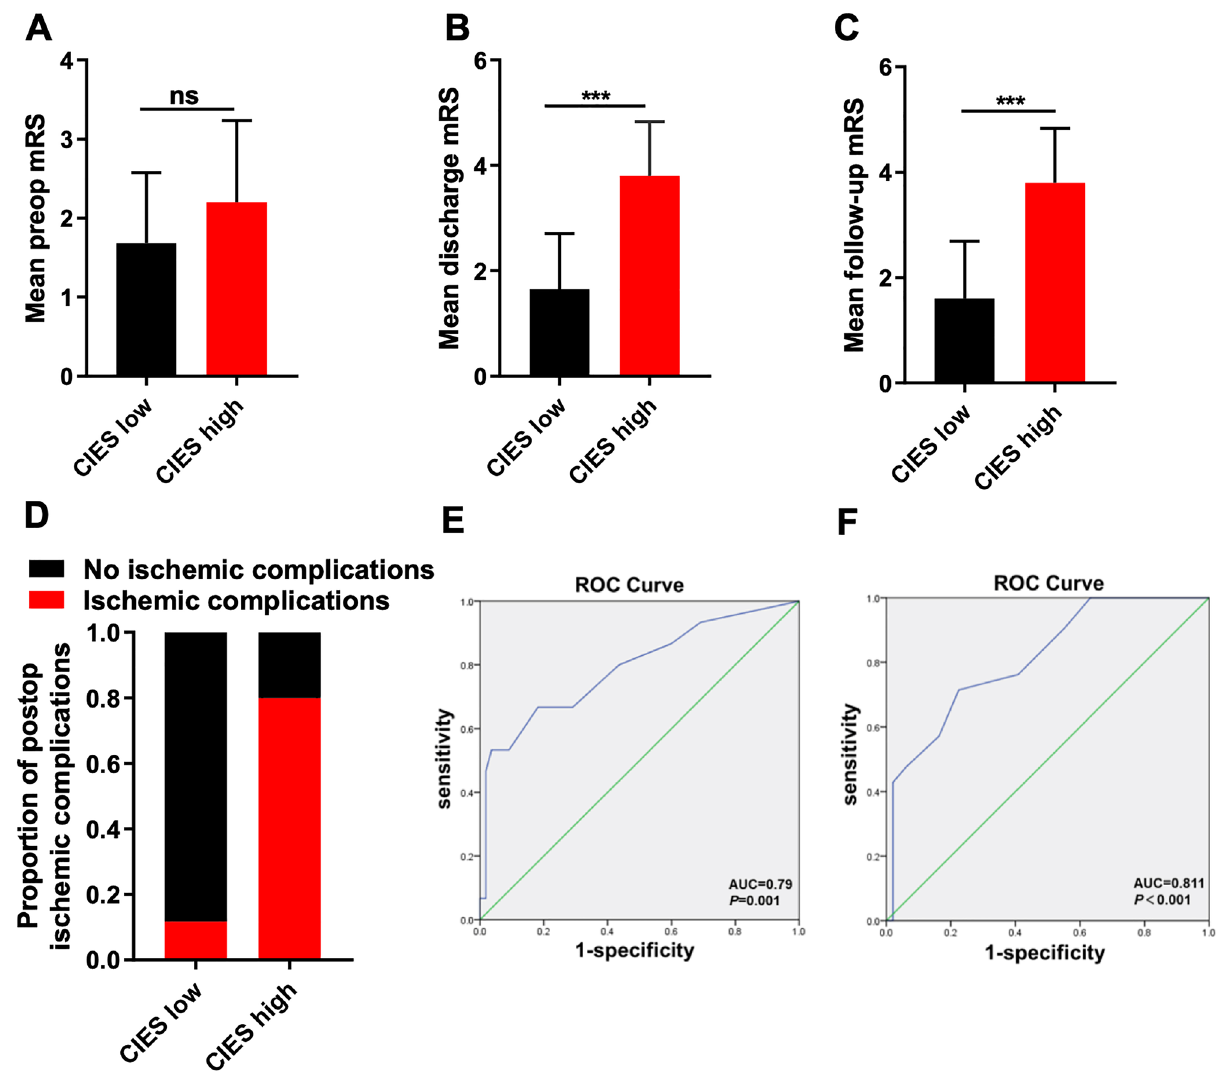
( B ) Comparison of discharge mRS between low and high CIES subgroups (*** p < 0.001, Mann–Whitney U test). ( C ) Comparison of follow-up mRS between low and high CIES subgroups (*** p < 0.001, Mann–Whitney U test. ( D ) The difference of incidence of postoperative ischemic complications between low and high CIES subgroups. ( E , F ) AUROC for CIES as a predictor for postoperative ischemia ( E ) or a high follow-up mRS score ( F